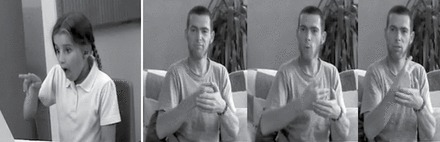
(a) Predicate containing lexical sign LOOK-AT and simultaneous constructed action. (b) Predicate containing lexical sign WALL followed by DC depicting Wallace hitting the wall.